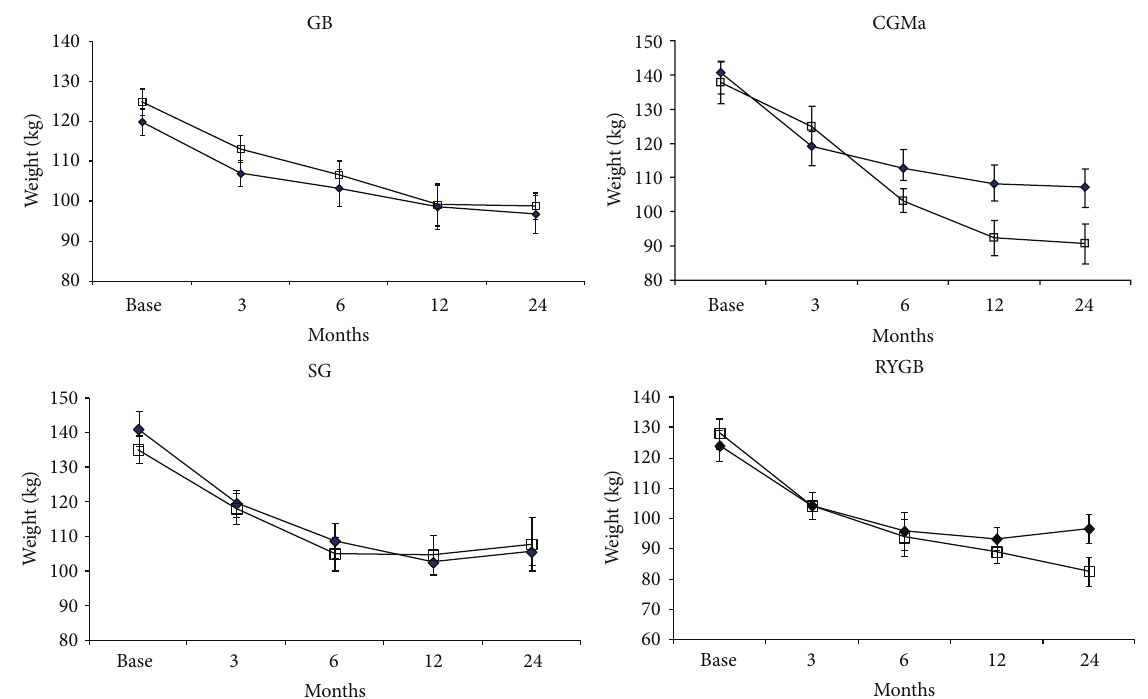
Figure 3: Changes in weight (mean ± SEM) induced by the four different types of bariatric surgery in nondiabetic and diabetic obese patients. Gastricbanding(GB),calibratedgastrectomytypeMason(CGMa),sleevegastrectomy(SG),andRoux-en-Ygastricgypass(RYGB).( ◻ )Obese patients without diabetes; ( ◼ ) obese patients with type 2 diabetes.